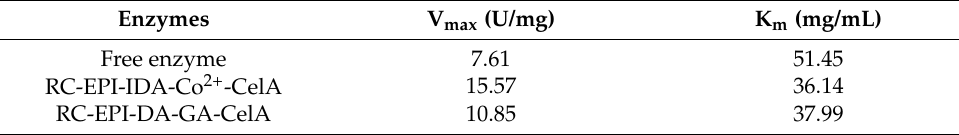
Figure 10. Lineweaver Burk plot mapping of free and immobilized CelA endoglucanase. Table 2. Kinetic parameters of free and immobilized CelA